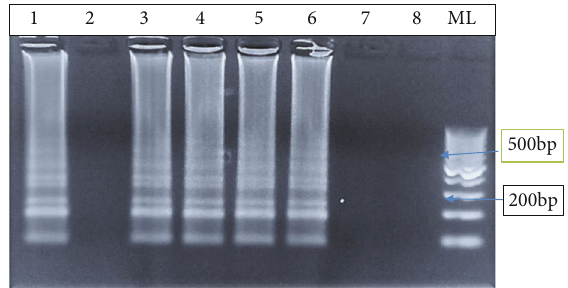
Figure 3: LAMP ampli fi cation results on agarose gel. Lane 1: positive control of W. bancrofti DNA; lane 2: negative control; lanes 3, 4, 5, and 6: positive specimens; and lanes 7 and 8: negative results. Lane ML is the molecular weight marker of